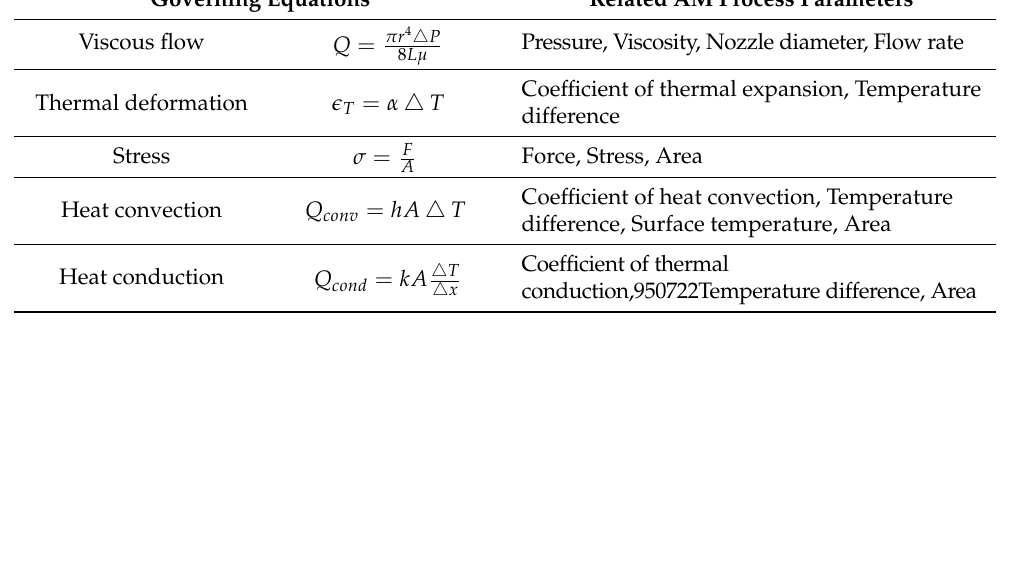
Table 1. Process parameter identification from governing equations of physical phenomenon in AM.